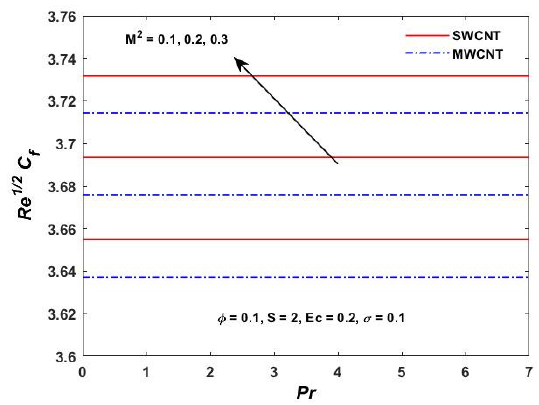
Figure 15. 𝑀 (cid:2870) verses Prandtl and 𝑅𝑒 (cid:2869)/(cid:2870) 𝐶 (cid:3033) . Figure 15. M 2 verses Prandtl and Re 1/2 C f